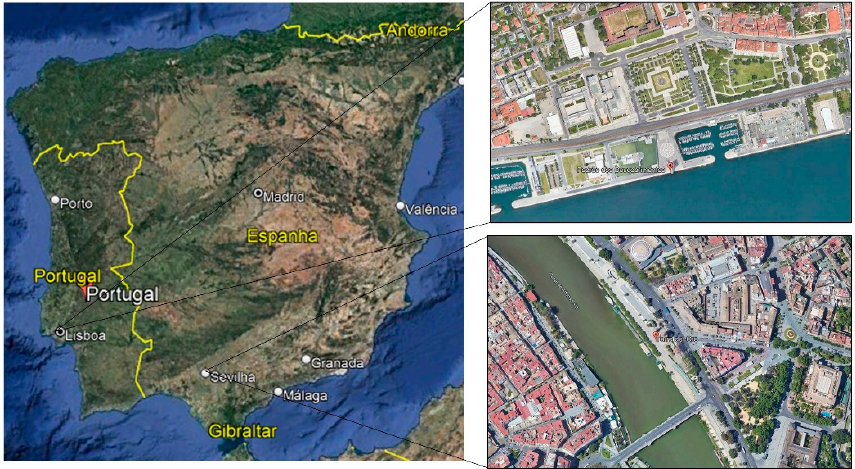
Figure 1. Geographical location of Padrão dos Descobrimentos in Lisbon (Portugal), and the Torre del Oro in Seville (Spain).